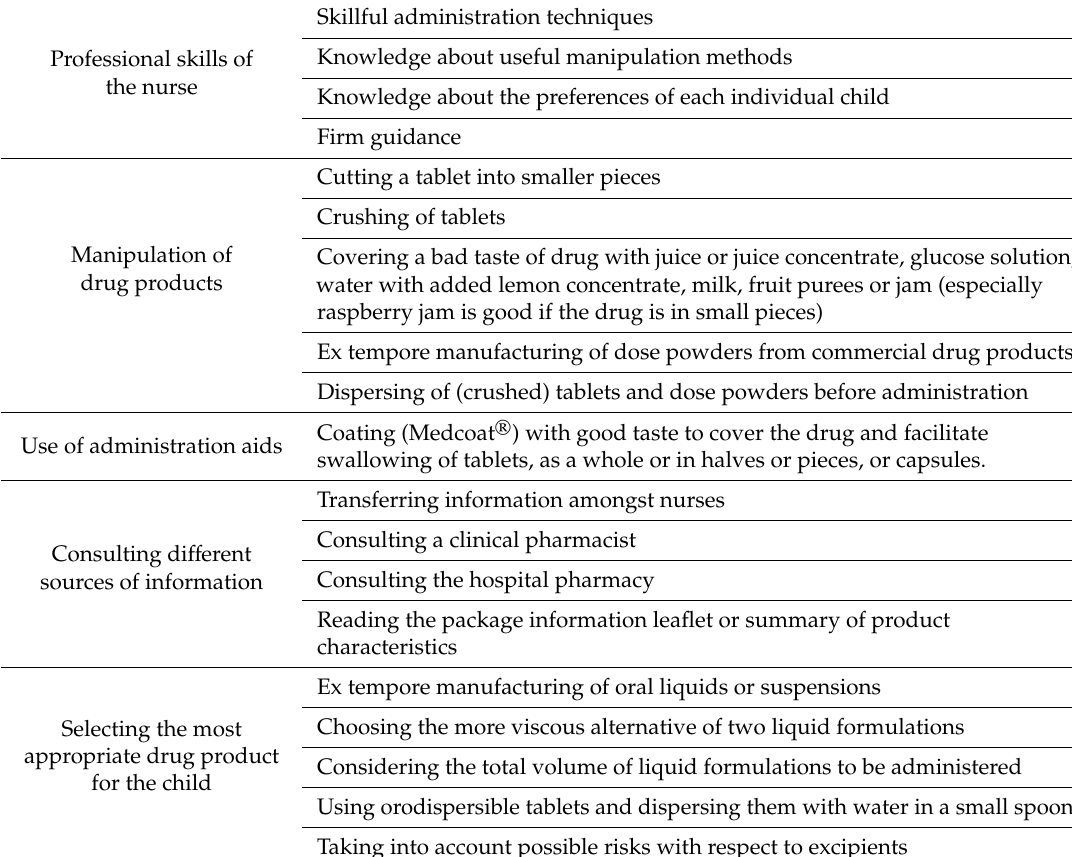
Table 4. Means to improve medication adherence and successful drug